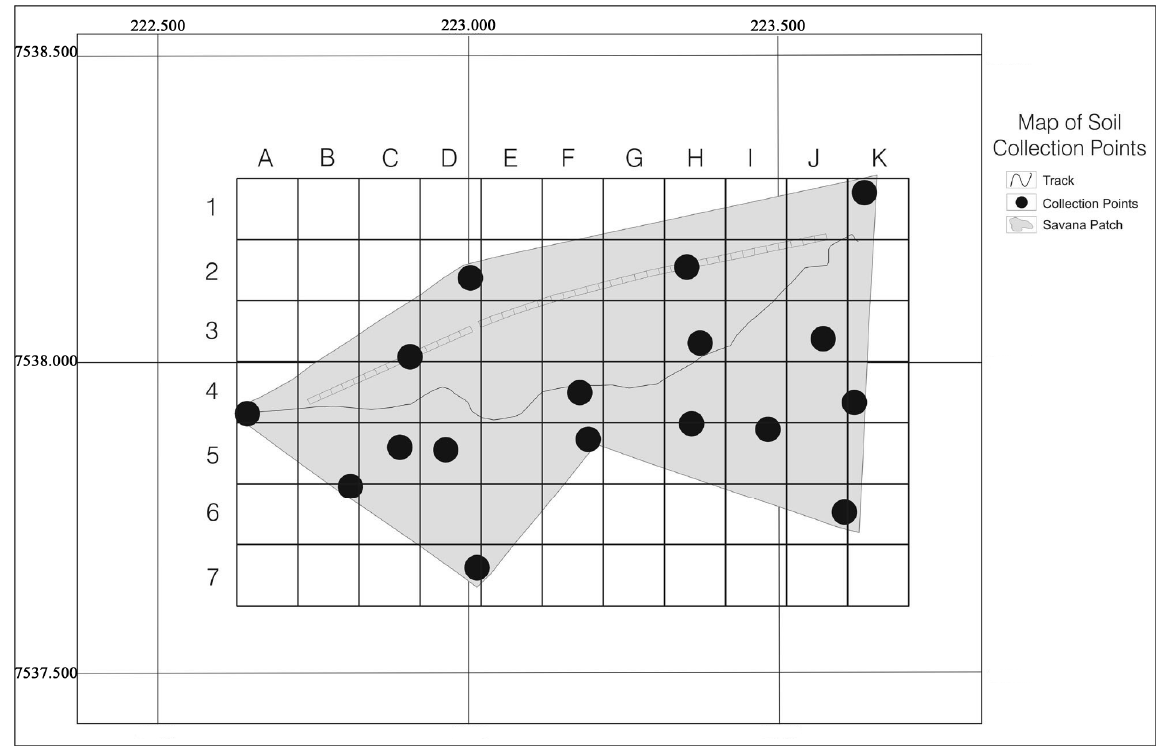
Fig. 2 – Localization of soil collection sites in the Corumbataí fragment in 200 m 2 regular grids. The smaller numbers are Universal Transverse Mercator (UTM)